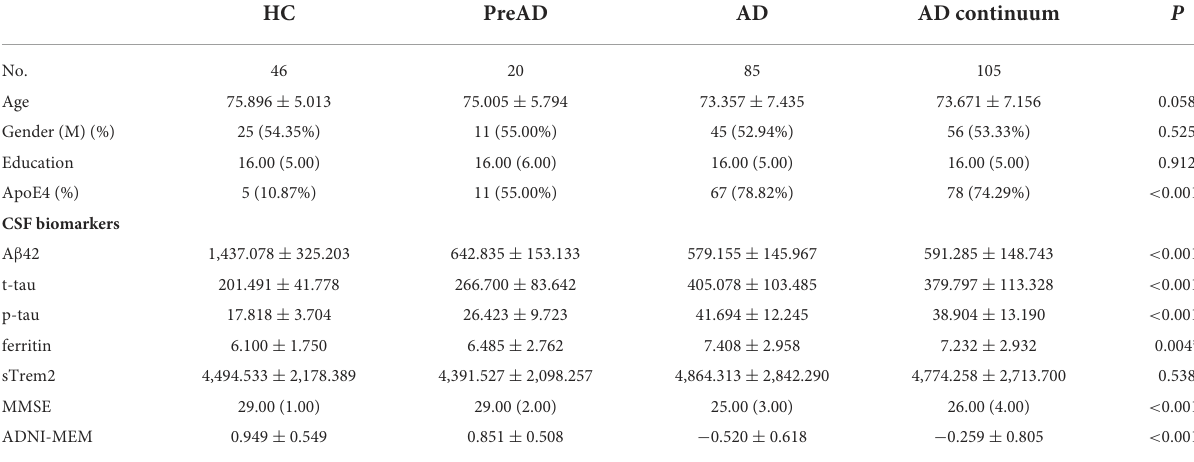
TABLE 2 Baseline characteristics of the included participants.